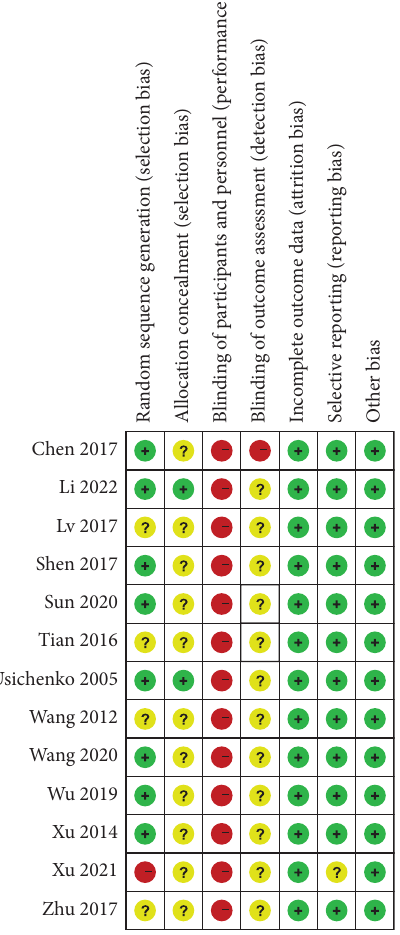
Figure 2: Risk of bias